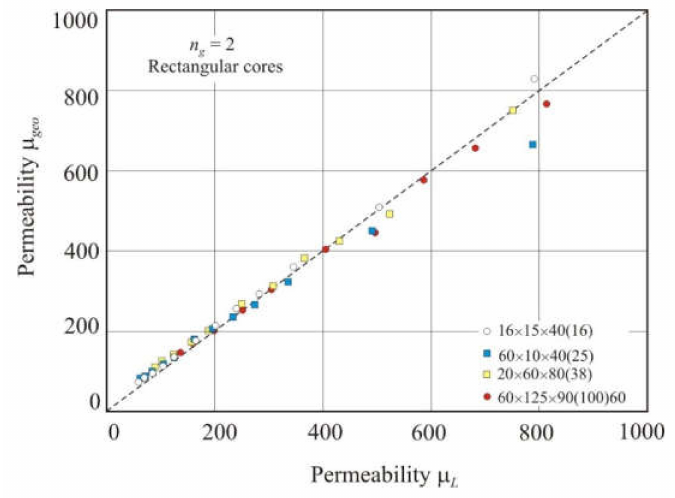
Figure 13. Relationship between geometric permeability µ geo and measured permeability µ L in nanocrystalline rectangular cores with two air gaps. The total air gap length l g was taken equal to ( l s + l o ), where l s is the spacer thickness, and l o is the residual air gap length. The dashed line corresponds to equation µ geo = µ L